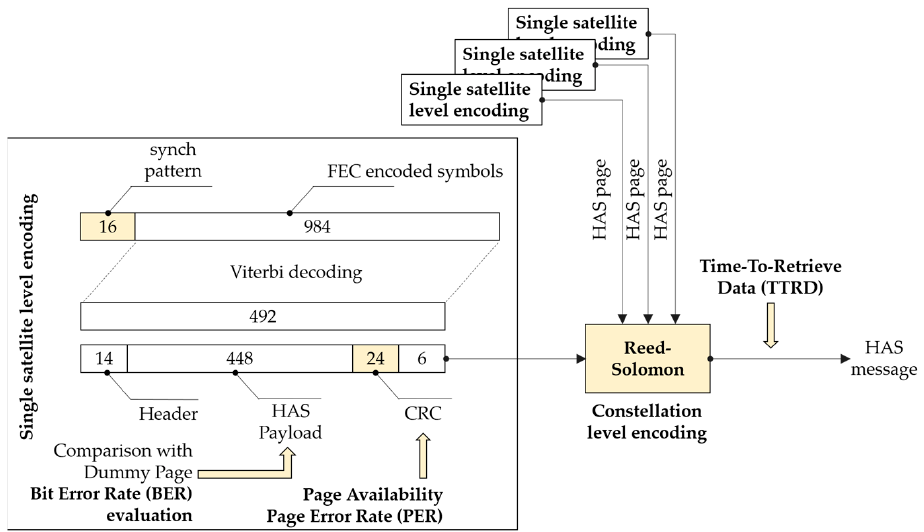
Figure 1. Different levels of encoding, error correction, and error detection implemented in the E6B HAS message transmission.